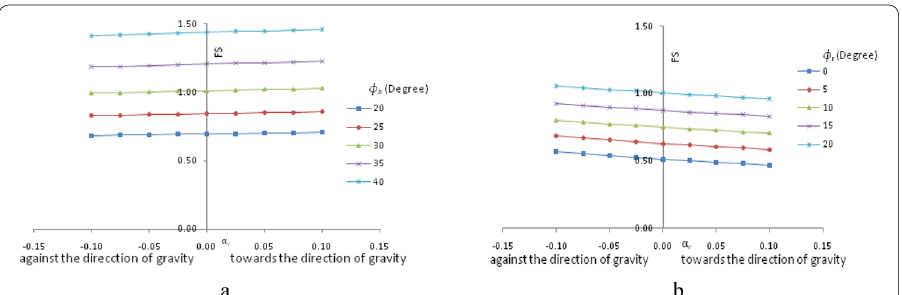
Fig. 12 FS vs α v on different values a φ b for case 1 and b φ r for case